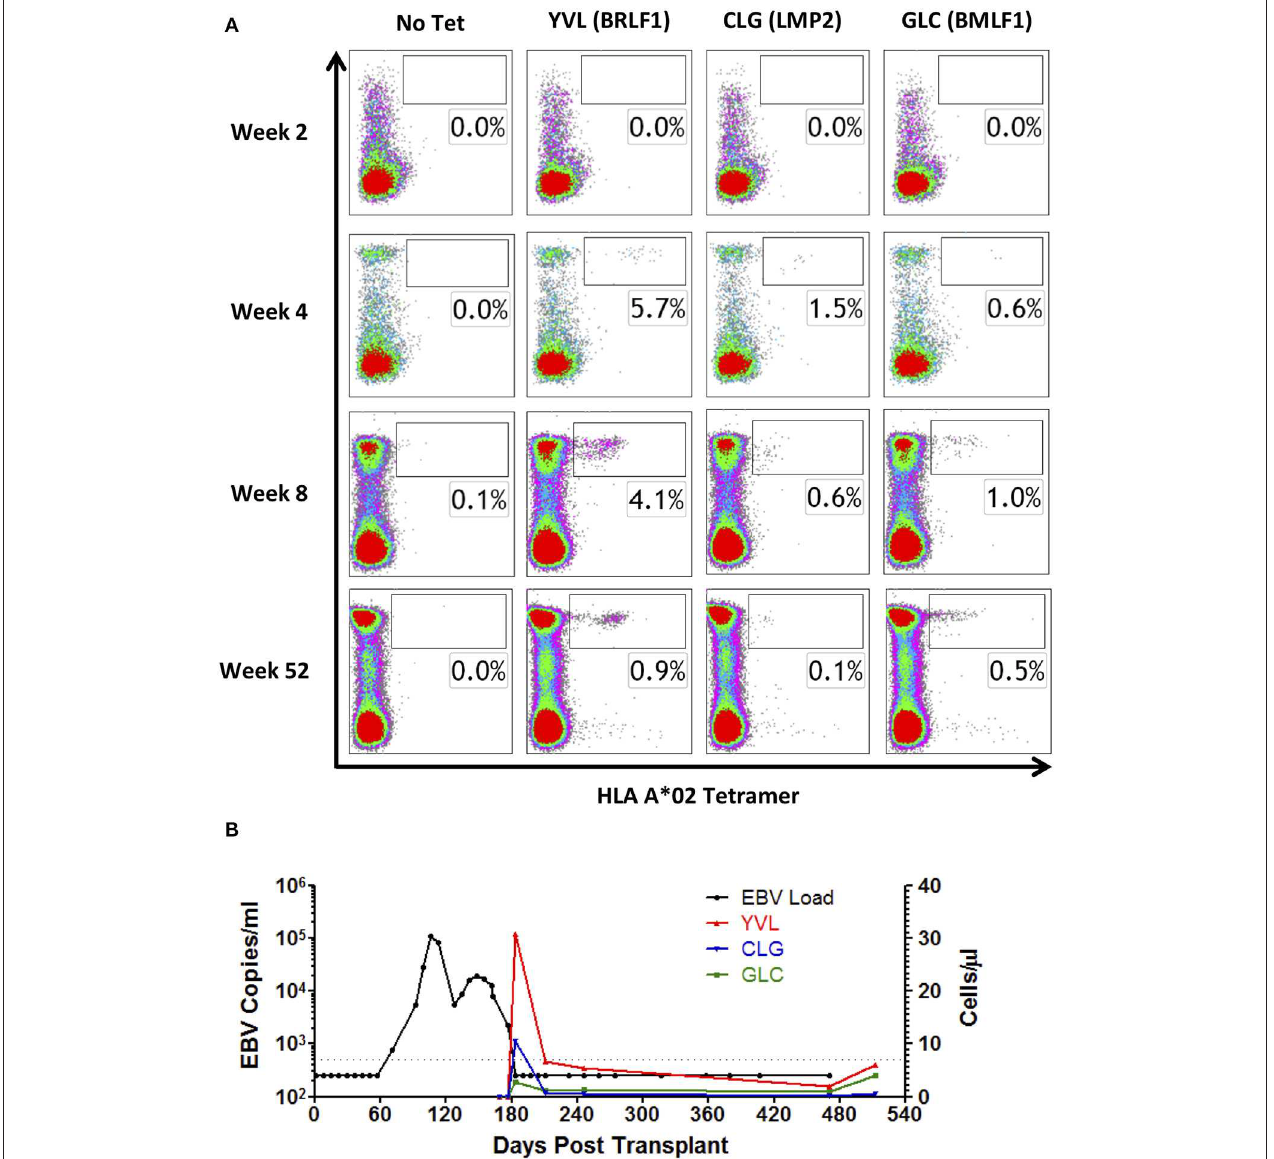
FIGURE 3 | MHC I tetramer analysis of EBV epitope-specific CD8 + T-cell responses following DLI. PBMCs from HLA A*02-positive Patient A were stained with HLA A*02 tetramers containing YVL (BRLF1), CLG (LMP2), and GLC (BMLF1) epitope peptides. (A) Depicted results show lymphocytes co-stained for CD8 + and tetramer, compared to a no tetramer control (left column). Cell populations within the boxes indicate the percentage of tetramer-positive cells within the CD8 + T-cell population. (B) Comparison of response in whole blood viral load with the absolute frequency of EBV-specific T-cells recognizing YVL (BRLF1), CLG (LMP2), and GLC (BMLF1) in cells/ µ l over time. Vertical dotted lines represent the time of